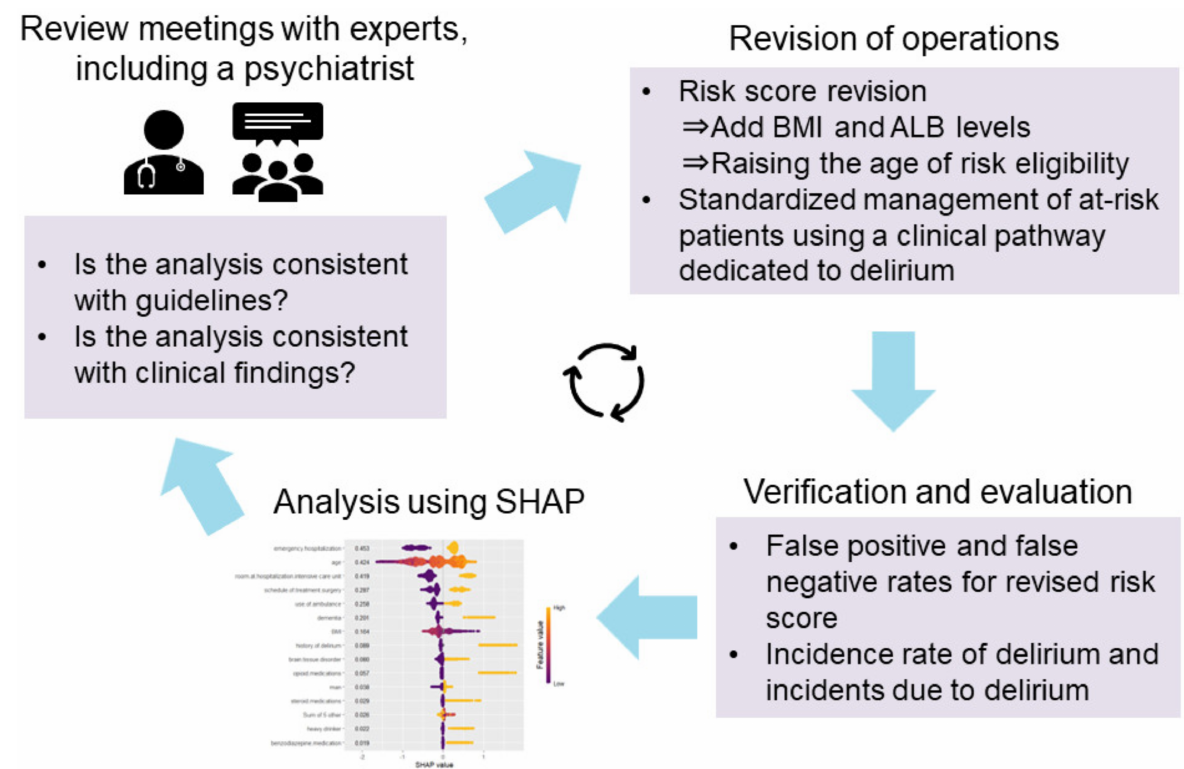
Figure 9. Model case for a learning health system focused on